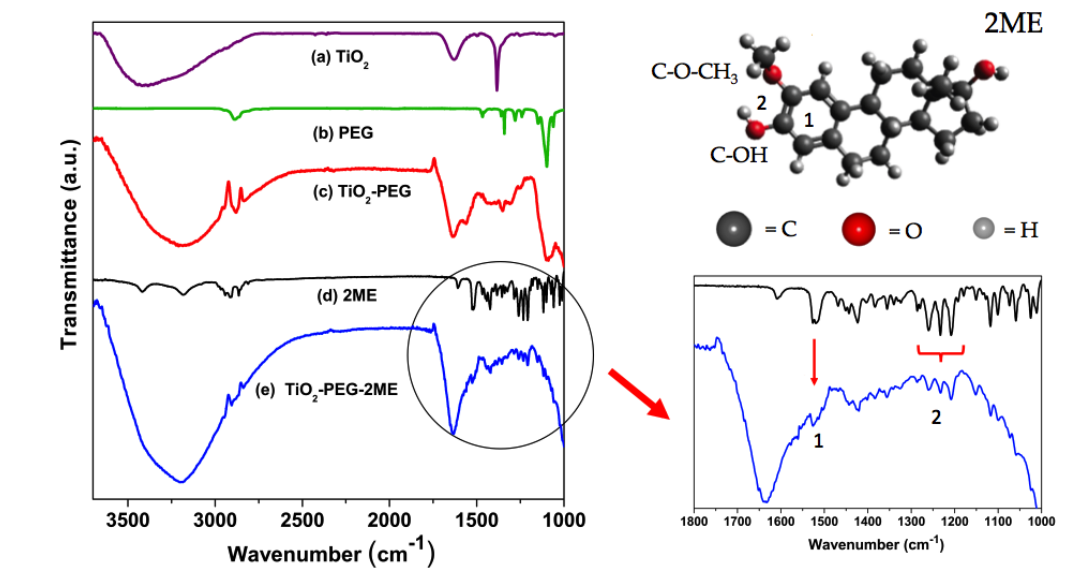
Figure 3. Fourier-transform infrared (FTIR) spectra for ( a ) TiO 2 ; ( b ) PEG; ( c ) TiO 2 –PEG; ( d ) 2ME, and ( e ) TiO 2 –PEG–2ME. The magnified view of ( d ) and ( e ) on the right side shows the IR spectrum for TiO 2 –PEG–2ME in the range 1800–1000 cm − 1 ; in this zone, it is possible to identify the peaks associated with aromatic ring C=C stretching vibration in of 2ME (zone 1) and tree peak associated with the methoxy group O-CH 3 and the alcohol group C-OH (zone 2); these zones are showed in the upper right side in an schematic representation of the 2-Methoxyestradiol molecule. The color of spheres (gray, red and light gray) represent Carbon (C), Oxigen (O) and Hydrogen (H)